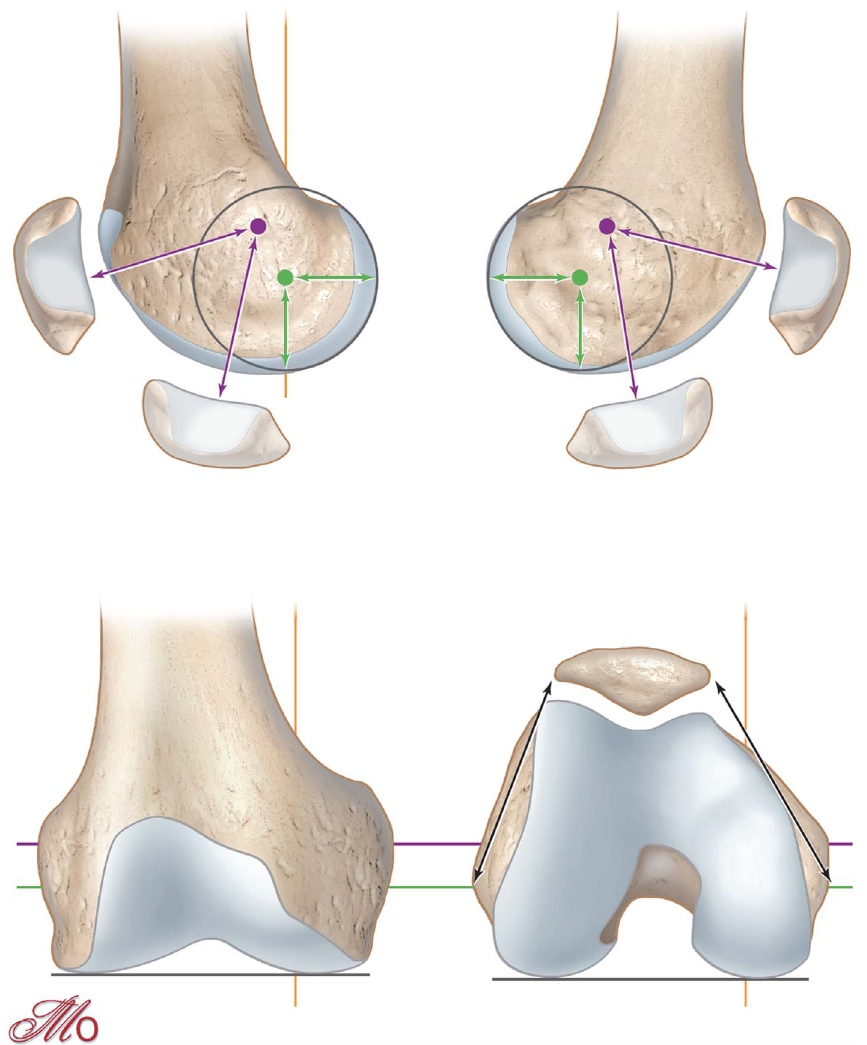
Figure 1. The femoral transverse axis about which the tibia extends and fl exes is the most distal and posterior (Green line). The femoral transverse axis about which the patella extends and fl exes is more proximal and anterior (Violet line). The longitudinal axis about which the tibia externally and internally rotates on the femur passes through the medial femorotibial compartment (Yellow line). All three axes are either perpendicular or parallel to the joint lines